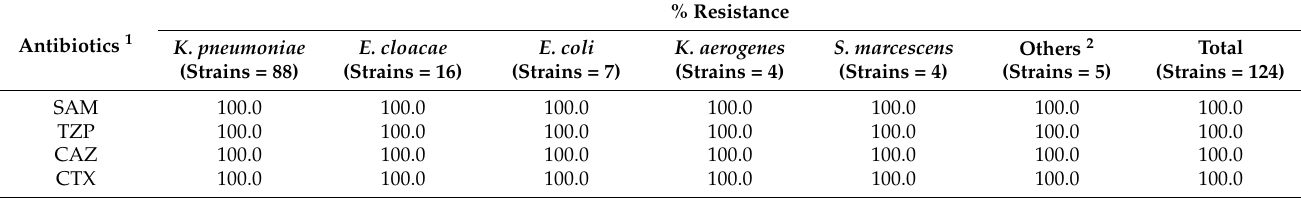
Table 2. Antimicrobial resistance rate (%) according to bacterial species ( n =